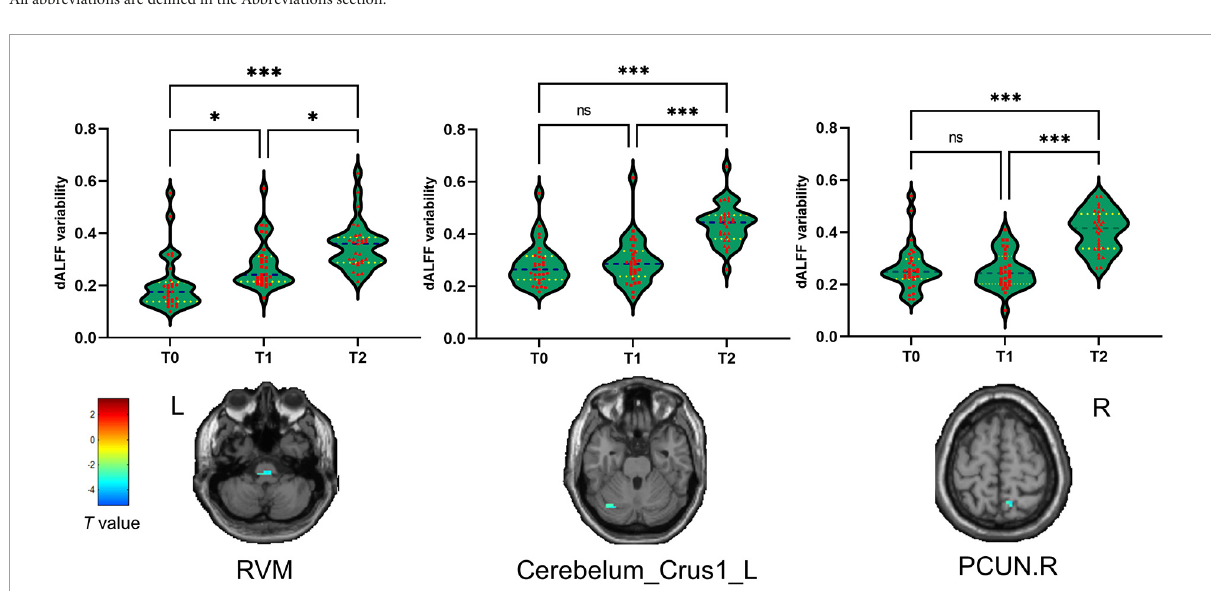
FIGURE3 The dALFF variability significantly during the different periods of treatment. ∗ p < 0.05, ∗∗∗ p < 0.001. The cool color represents decreased dALFF variability values. T0, the time point at baseline; T1, the time point after the first acupuncture session; T2, the time point after the 12th acupuncture sessions. All abbreviations are defined in the Abbreviations section.